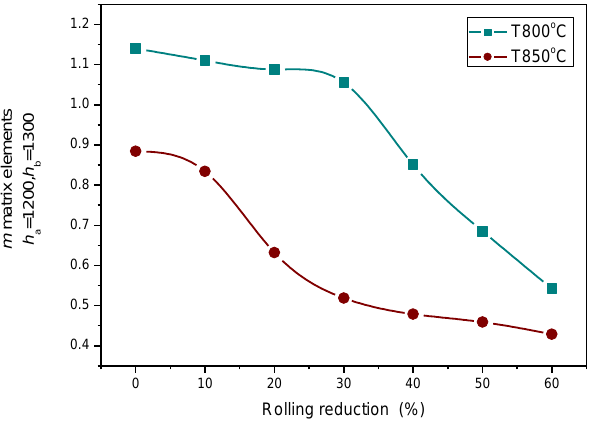
Figure 11. Modification of MAT descriptors as functions of rolling reductions for two annealing temperatures.